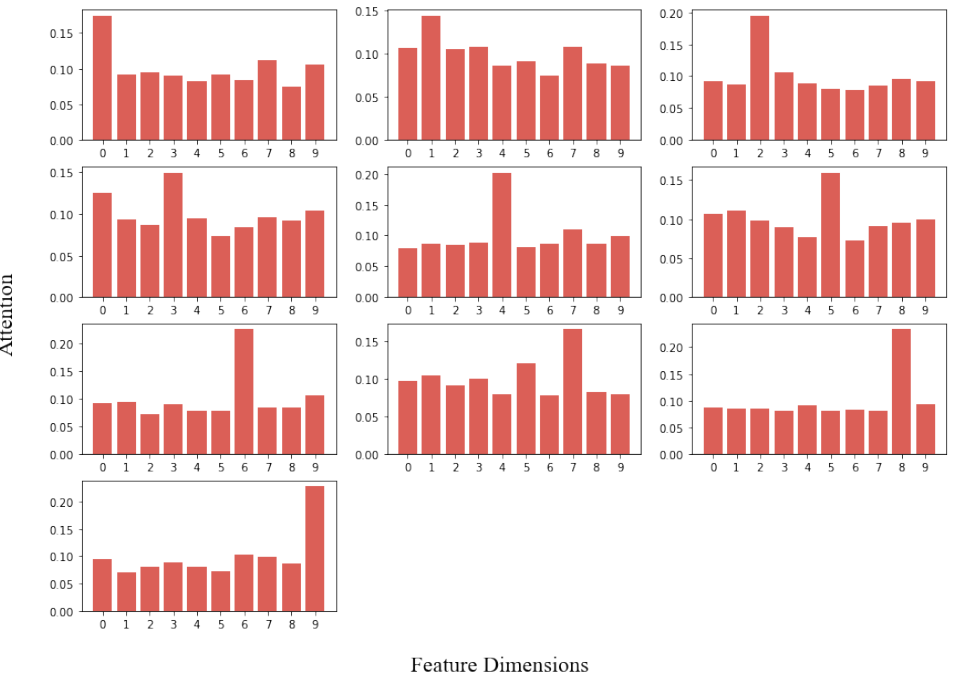
Figure 2. Distribution of attention weights after introducing the attention